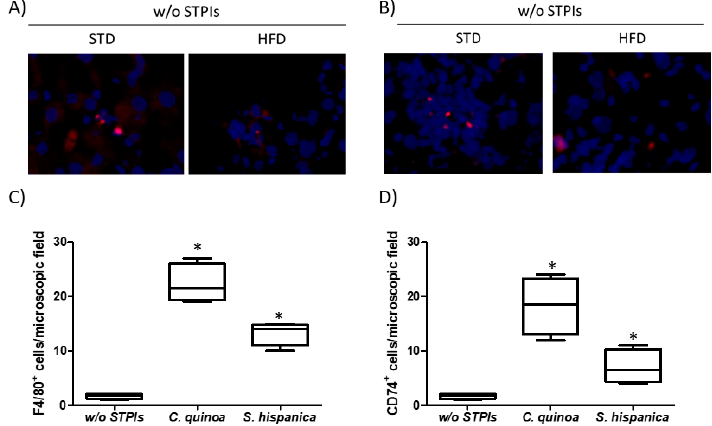
Figure 4. Immunological changes in hepatocarcinoma-developing mice administered with protease (serine-type) inhibitors (PIs). Number of hepatic single cells stained for ( A,C ) F4/80 and ( B,D ) CD74 (MHC-II invariant chain) quantified by immunofluorescence analysis. Cell counting was performed in 5 to 10 different microscopic fields from each of the stained sections per group. Results are expressed as mean ± SEM ( n = 4 − 6). * Indicates statistical differences (Tukey–Kramer’s test, p < 0.05) to DEN/TAA-treated animals not receiving STPIs.